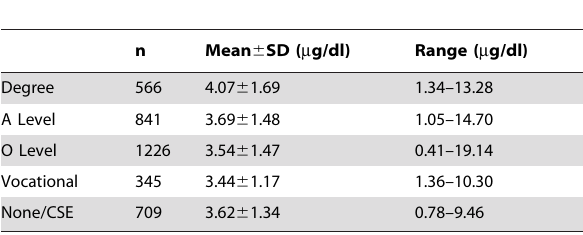
Table 1. Maternal BLL by highest maternal educational